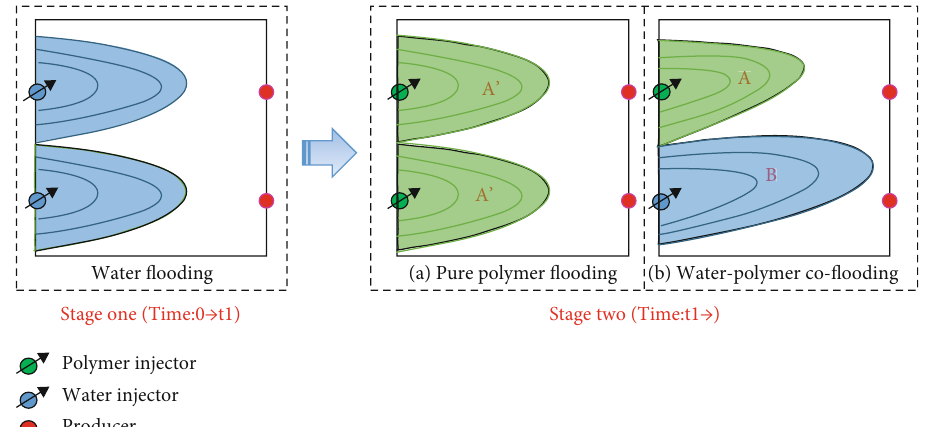
Figure 1: Schematic distribution of injected fl uid.